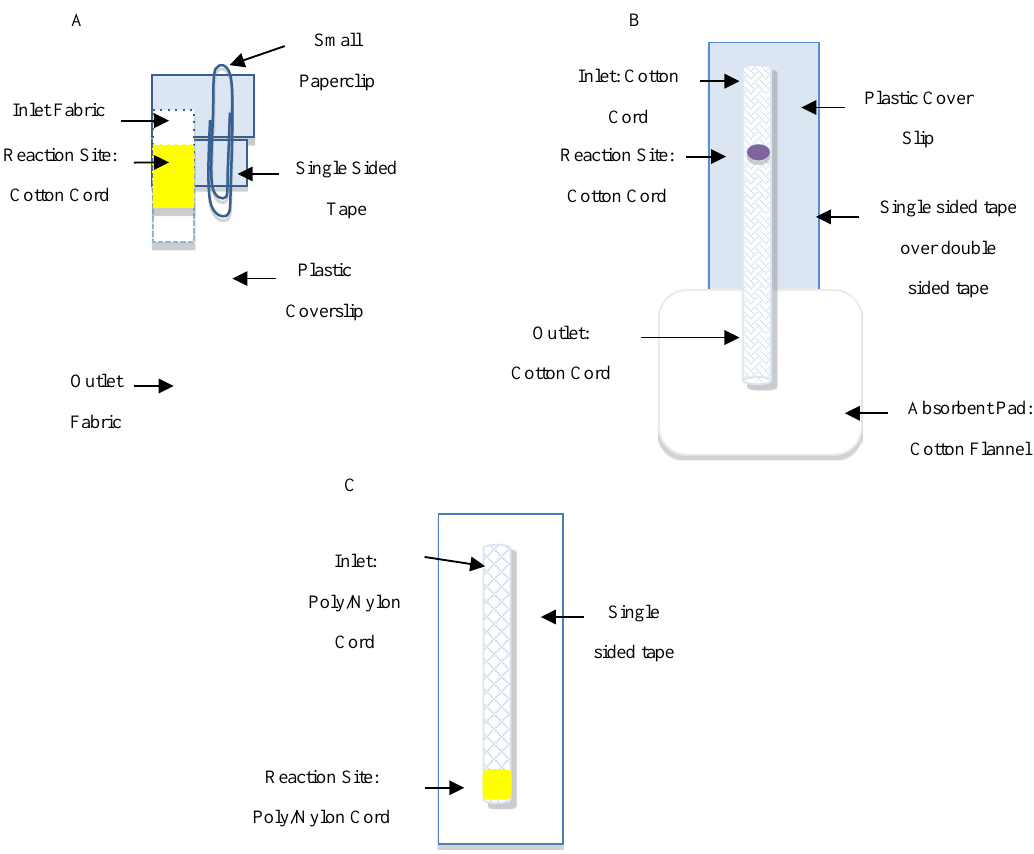
Figure 1. Schematic of µCAD for the detection of ( A ) biotinylated goat anti-mouse IgG, ( B ) rabbit IgG antibodies, and ( C ) glucose.